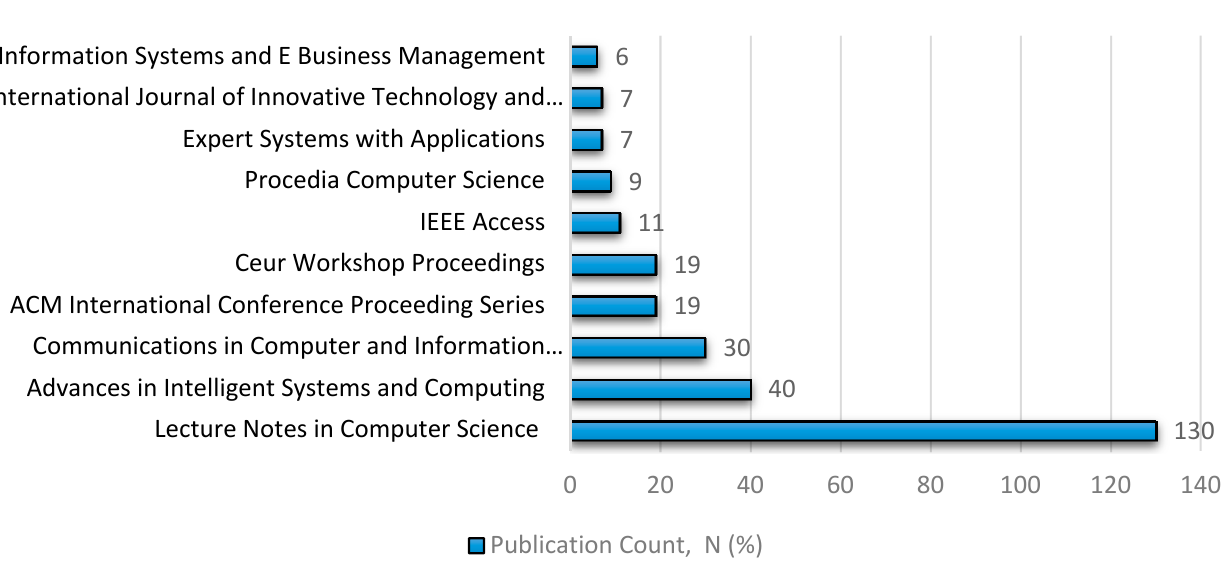
Figure 10. Analysis based on Scopus source titles.